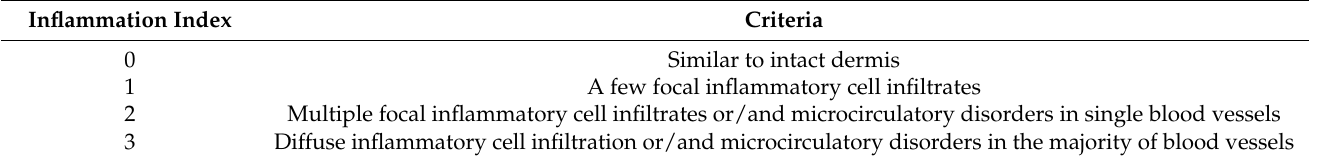
Table 1. Criteria of semiquantitative histological scoring of the scar tissue. Inflammation Index Criteria 0 Similar to intact